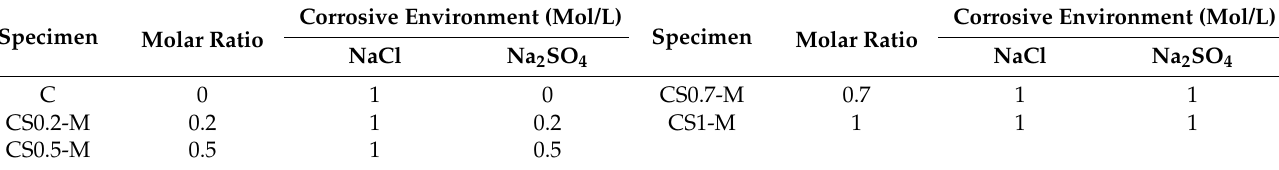
Table 3. Corrosion conditions of